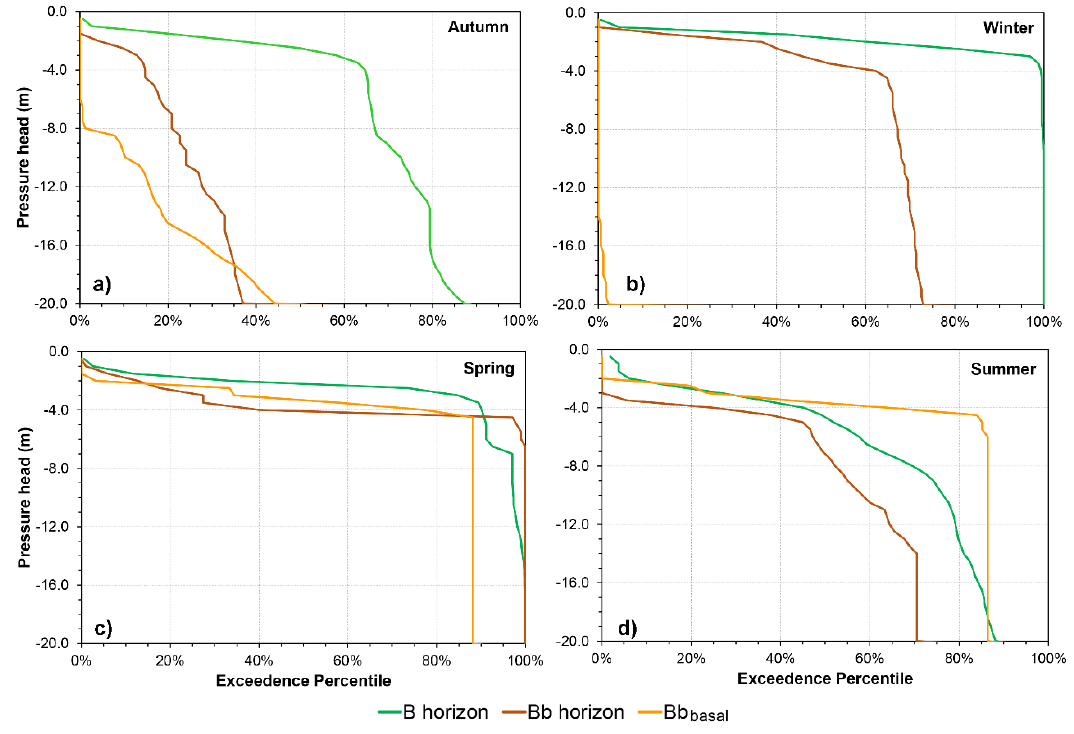
Figure 7. Seasonal duration curves (DCs) of soil pressure head data for B, Bb, and Bb basal soil horizons related to: autumn ( a ), winter ( b ), spring ( c ), and summer ( d ), modified from [38].